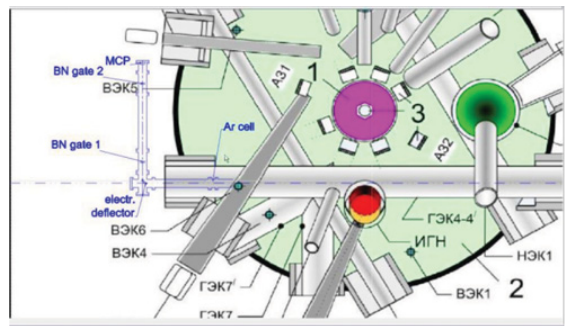
Figure 2. BoB setup at the Gatchina PIK reactor consisting of an Ar gas cell, an electrostatic focusing element, a pulsed electric deflector, a BN gate chopper and a MCP